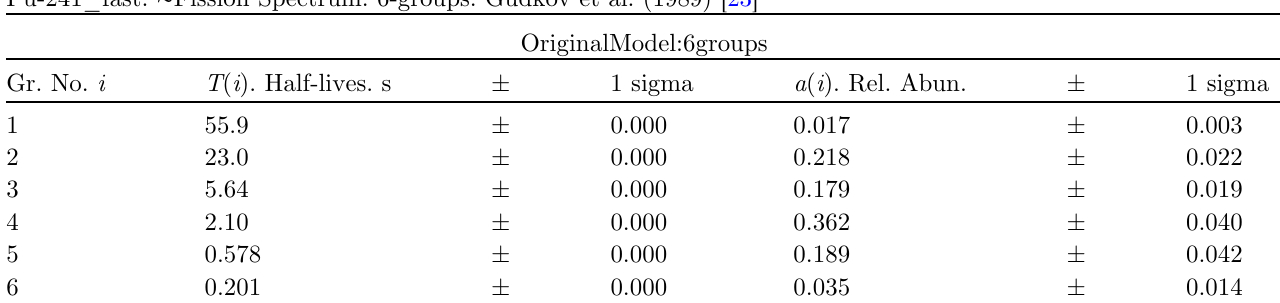
Table 12. Relative abundances and half-life of delayed neutrons (6-group DN data set) for fast neutron induced fi ssion of 241